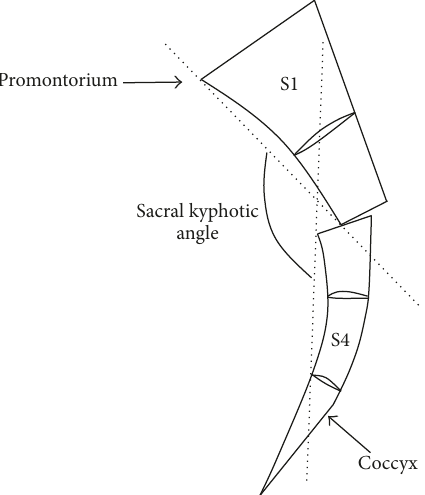
Figure 2: Schemata of sacral kyphotic angle . We defined the sacral kyphoticangleastheanglebetweenthelinefromthesacralpromon- torium to the anterior edge of the proximal fracture fragment and the line from the anterior edge of the distal fracture fragment to the caudal edge of the fourth sacral body in a midline sagittal reconstructed computed tomography